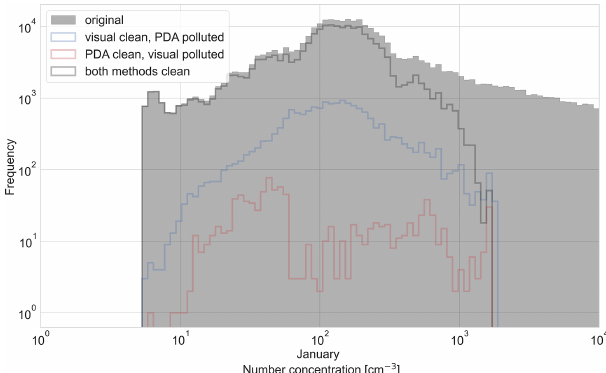
Figure 9. Comparison of the visual inspection method to the PDA on the dataset of the CPCf of ARM. Original data are shown in gray. The blue contour line shows the fraction of data points where only the visual inspection method but not the PDA considered data to be clean (6%). The red contour line shows the opposite, i.e., the frac- tion of data points where only the PDA but not the visual inspection method considered data to be clean ( < 1%). The dark gray contour line shows the fraction of data points where both methods consid- ered data to be clean ( ∼